Question: From the figure, is the trend upward or downward?
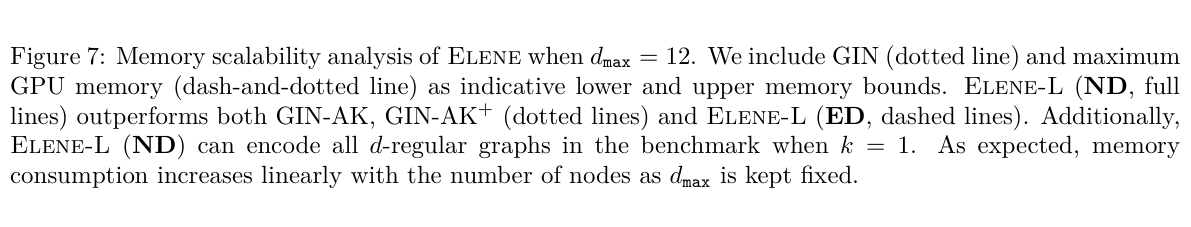
Answer: increasing